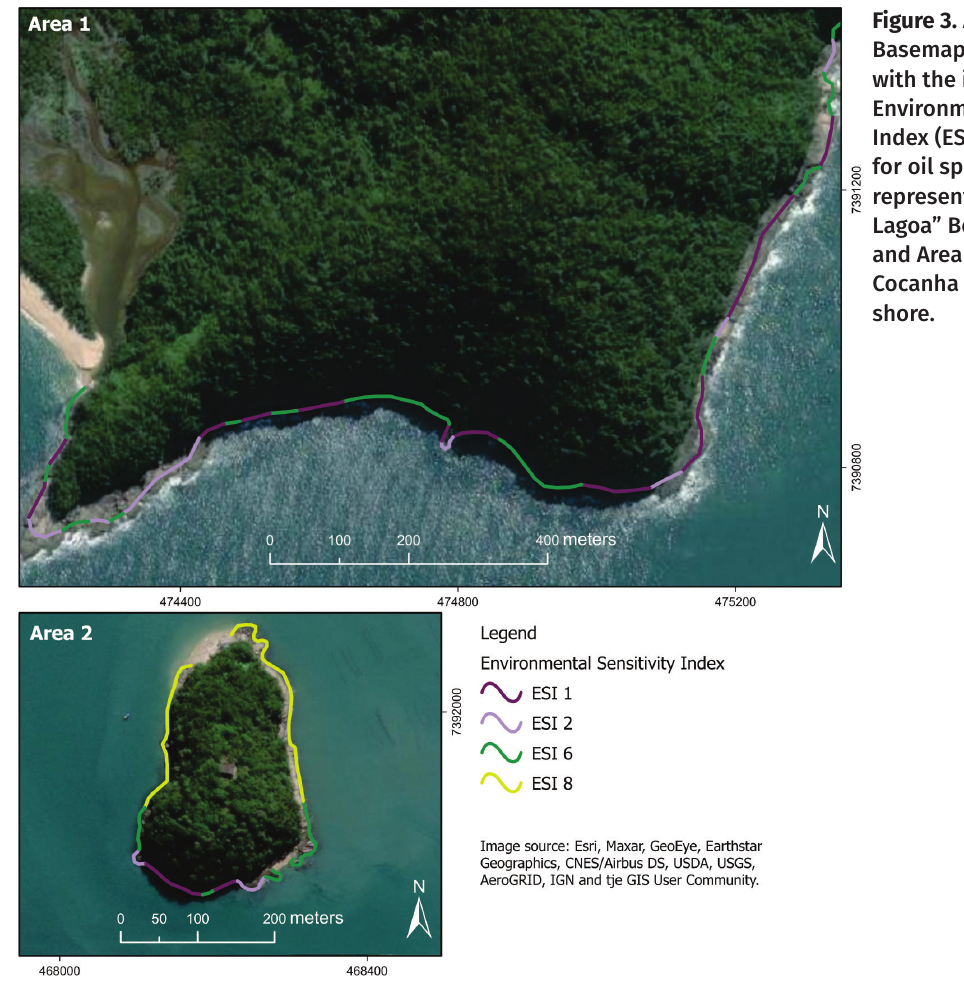
DRONES AND ENVIRONMENTAL SENSITIVITY MAPPING